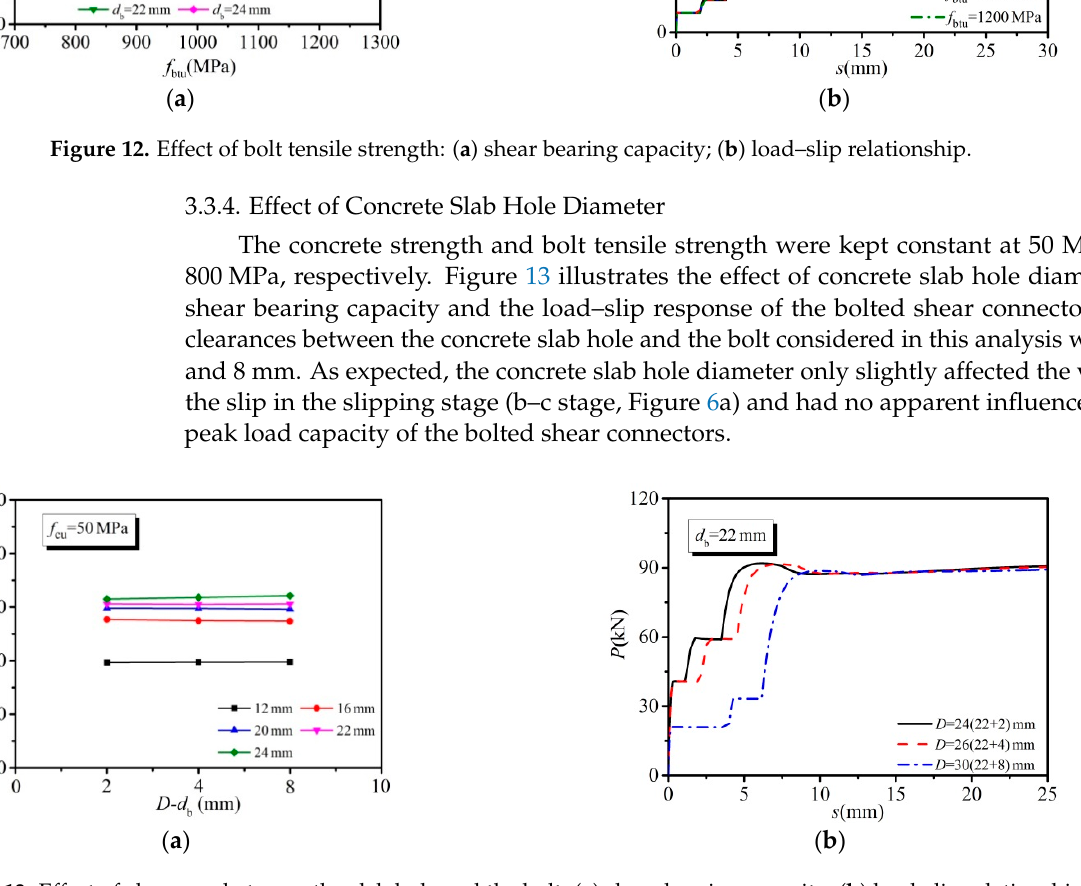
Figure 13. Effect of clearance between the slab hole and the bolt: ( a ) shear bearing capacity; ( b ) load-slip relationship.